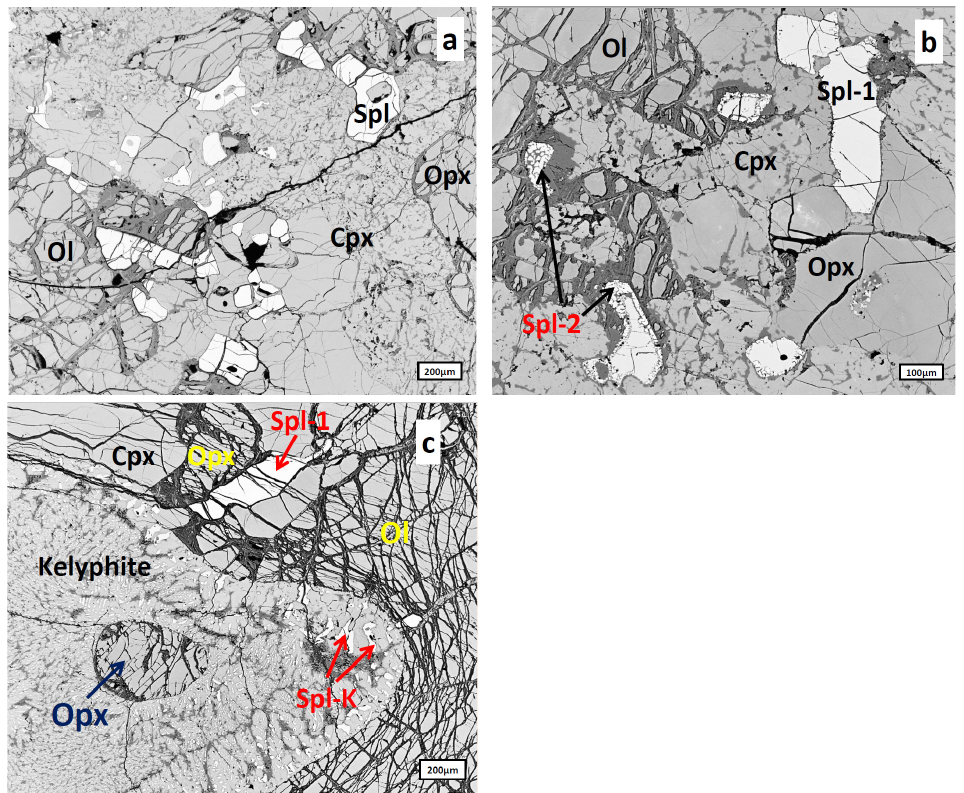
Figure 5. Types of spinels from Spl-Grt lherzolites: ( a ), Primary spinel (Spl) represented by clean homogeneous grains; ( b ), Primary spinel grains (Spl-1) surrounded by the thin sporadic rim of secondary spinel and completely resorbed spinel grains (Spl-2); ( c ), Irregular spinel grains (Spl-K) inside kelyphite rim replacing garnet; primary spinel (Spl-1) is also present here. A spongy rim around clinopyroxene (Cpx) can be seen in this lherzolite type (see [4]). Ol, olivine; Opx, orthopyroxene. Spinels from the kelyphite rim are compositionally similar to the mineral